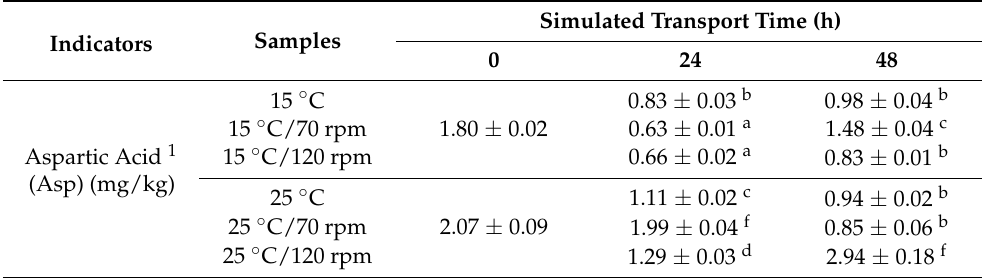
Table 3. Effects of temperatures and vibration rates on the free amino acids of the pearl gen- tian